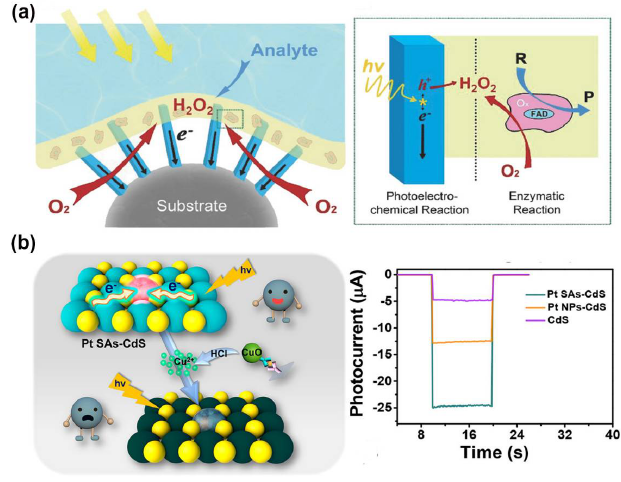
Figure 3. ( a ) Schematic illustration of the solid–liquid–air triphase bio-photoelectrode (TBP-electrode). Reprinted with permission from ref. [70]. Copyright 2018, John Wiley and Sons; ( b ) schematic illustration of the mechanism of Pt SA-CdS-based PEC biosensing platform and photocurrent responses for CdS, Pt SAs-CdS, and Pt NP-CdS. Reprinted with permission from ref. [80]. Copyright 2021, American Chemical Society.